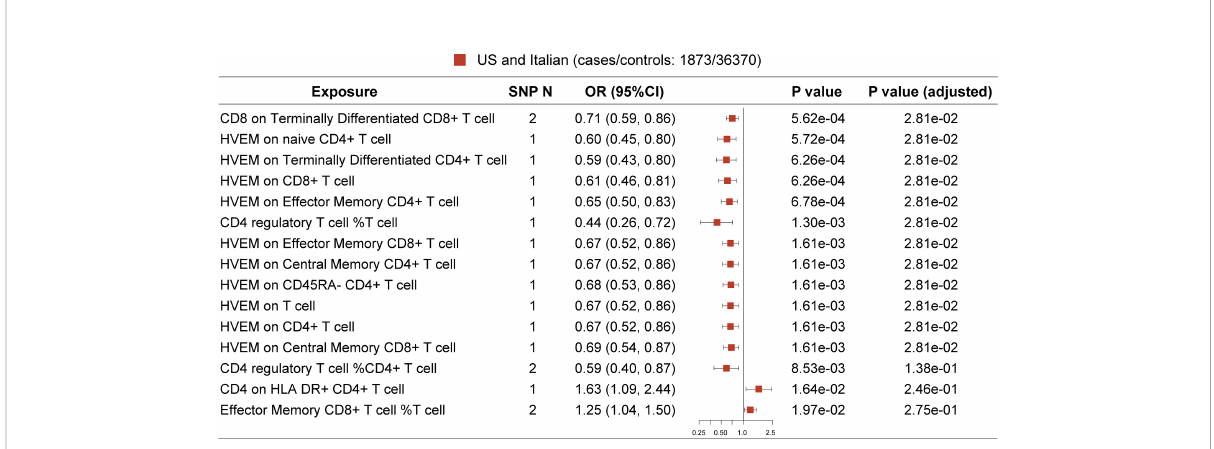
FIGURE 2 MR result in primary analysis (US and Italian patients). SNP N, number of SNP. The top 12 ranked T-cell traits by P value show protective effect on MG risk after false discovery rate (FDR)